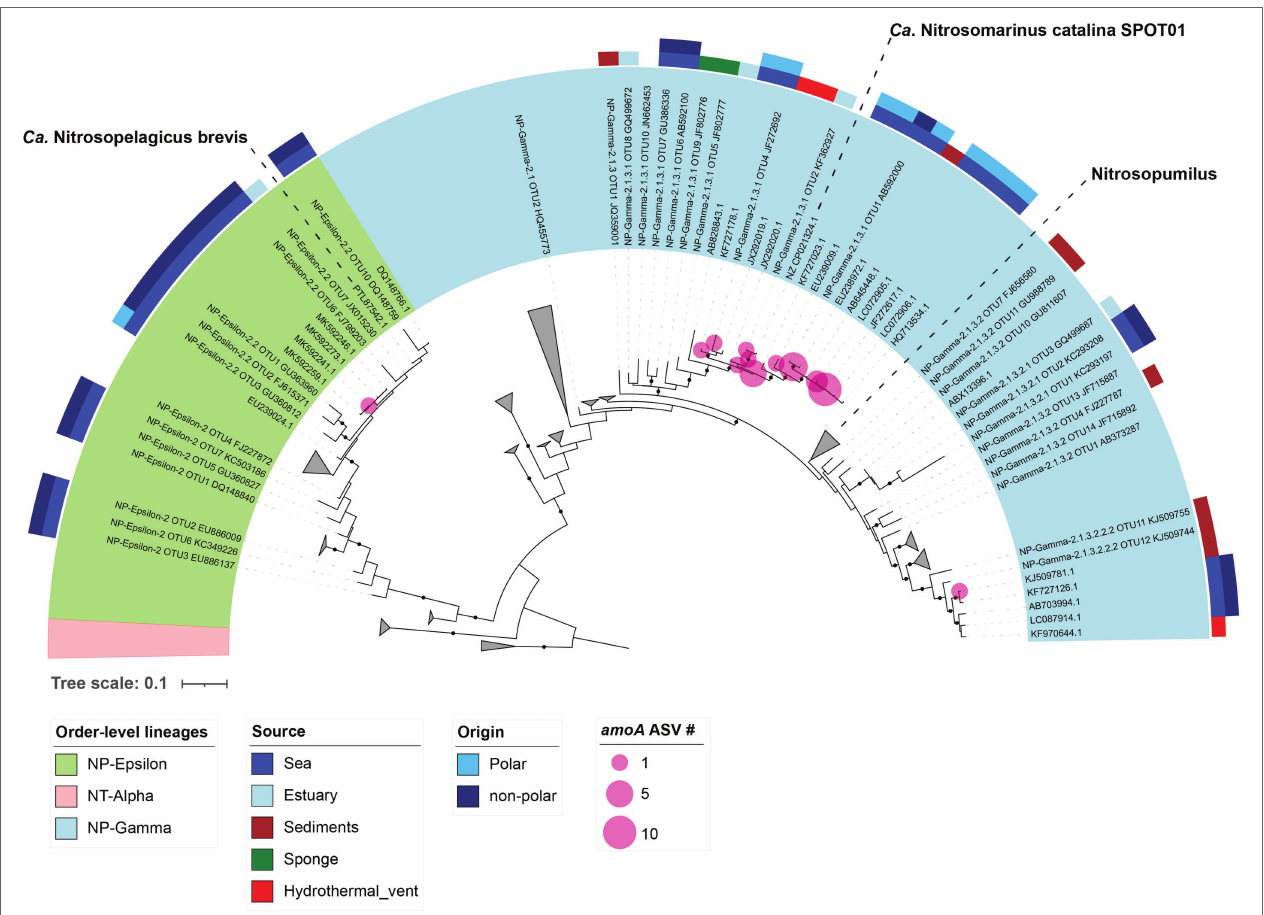
FIGURE 4 | Phylogenetic tree representing Archaeal amo A relatives. The green and blue rings refer to NP- ε and NP- γ orders-level lineages, respectively. The colored upper rings are related to the source, origin and latter clade affiliation of the AOA nitrifiers. Pink circles over nodes indicate AOA amo A ASVs number to each